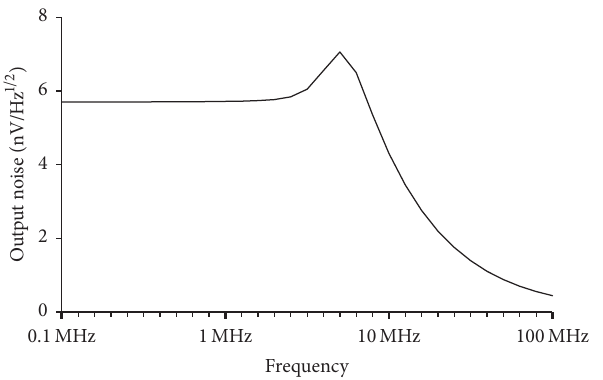
Figure 13: Output noise variation of proposed filter with frequency.